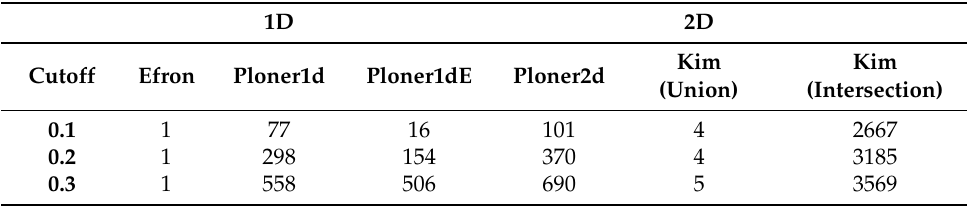
Table 8. Lymphoma data: The number of genes rejected by each